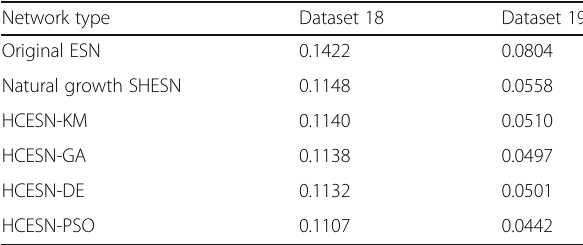
Table 4 NRMSE test error for prediction accuracy of laser